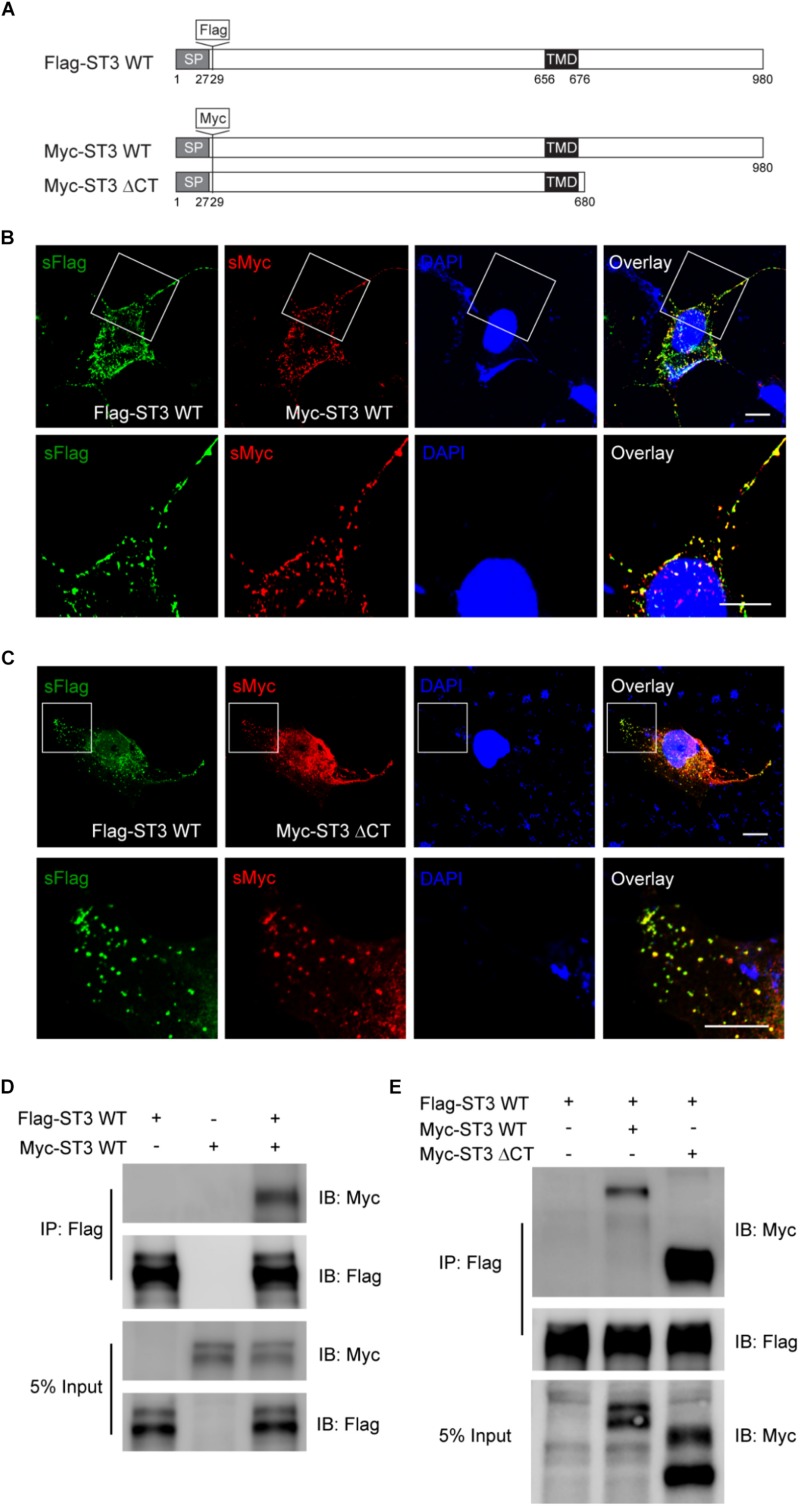
ST3 C-terminus is not required for ST3 homo-dimerization in heterologous cells. (A) Schematic of Flag-ST3 WT, Myc-ST3 WT, and Myc-ST3 ΔCT. Flag or Myc tag was inserted at amino acid 29. Signal peptide (SP). (B,C) Representative images (top panel, low magnification; bottom panel, high magnification of the boxed area at the top) showing surface (s) Flag-ST3 co-localized with surface Myc-ST3 (B) or surface Myc-ST3 ΔCT (C) in COS7 cells. Scale bar, 10 μm. (D,E) Co-IP assay of Flag-ST3 with Myc-ST3 (D) or Myc-ST3 ΔCT (E) in HEK293T cells. Cell lysates from HEK293T cells transfected with Flag-ST3, Myc-ST3, or Flag-ST3 together with Myc-ST3 or Myc-ST3 ΔCT, were immunoprecipitated with agarose beads conjugated with anti-Flag antibody, and then probed with indicated antibodies. IB, immunoblotting. Both Myc-ST3 (D) or Myc-ST3 ΔCT (E) were co-IPed with Flag-ST3. N = 3 independent repeats.